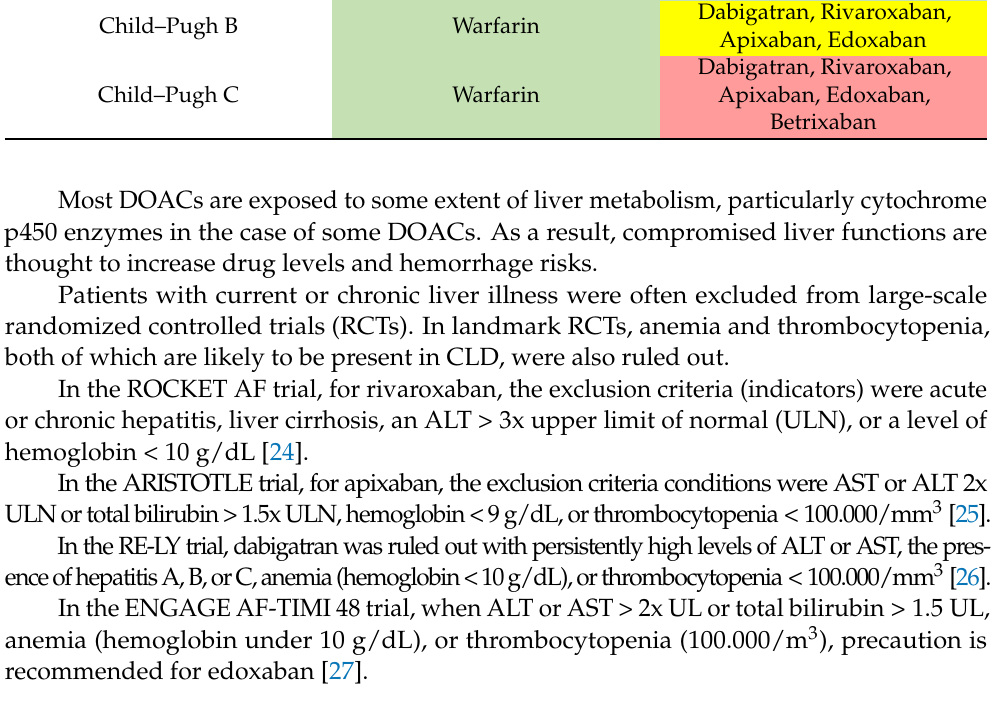
Table 1. Oral anticoagulant options related to Child–Pugh classes. Green: no dosage reduction needed, yellow: careful usage, red: contraindication. AVKs DOACs Child–Pugh A